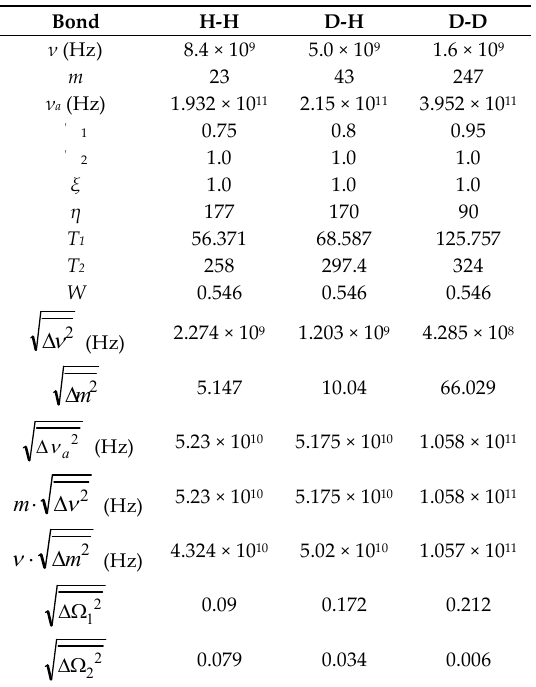
Table 2. Parameters for sequential deuteration of the hydrogen bond in the benzoic acid